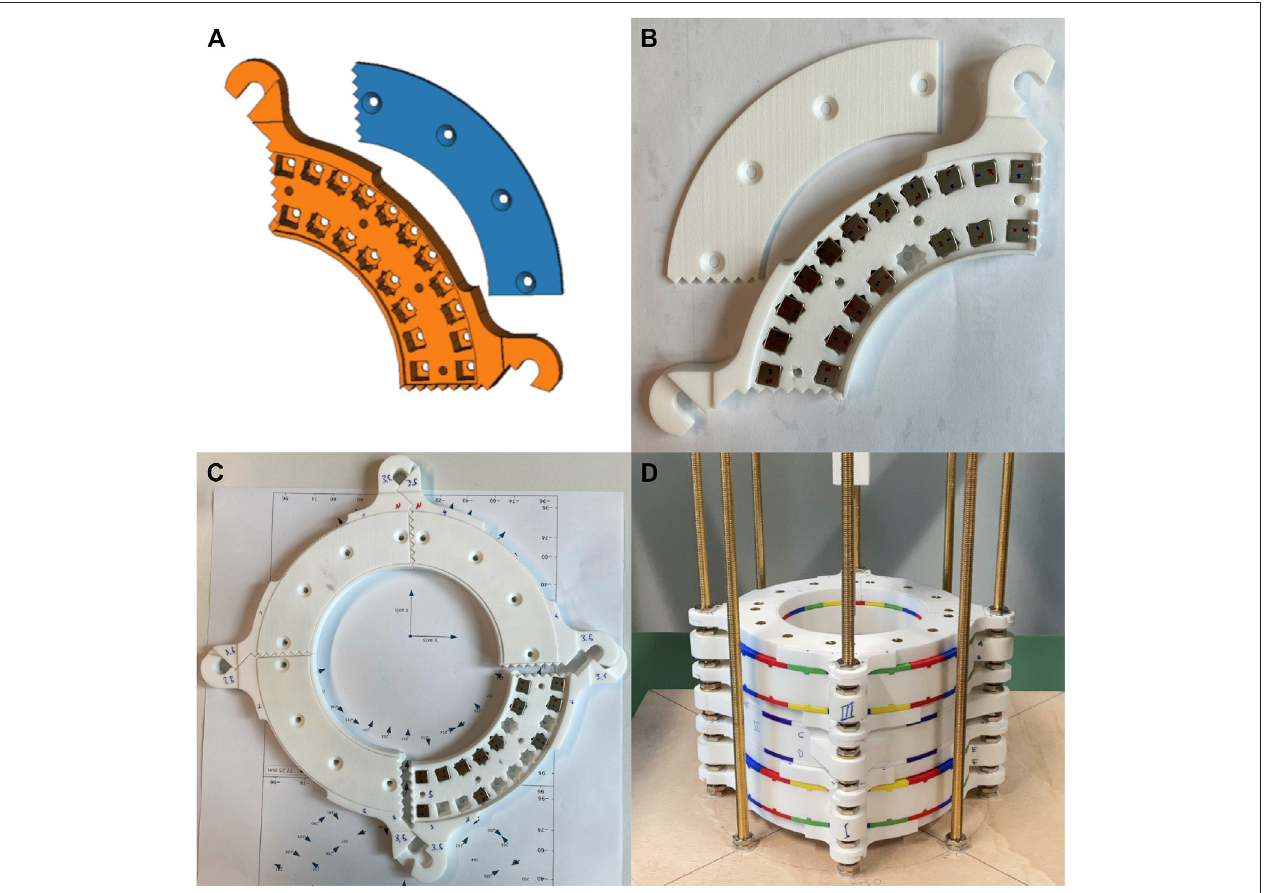
FIGURE 2 | Photographs and 3D renderings of the constructed and assembled shim pieces including the 9 mm cubic shim magnets. (A) CAD drawing of a single shim piece (orange) and cover (blue). Please note that the pockets are designed in a way that the shim magnets can be inserted in both radial (k (cid:1) 1) and Halbach (k (cid:1) 2) orientation. (B) 3Dprintedshimpiecewithinsertedmagnetsandthecoverremoved.Thepolesofthemagnetsaremarkedwithnorth(N)andsouth(S). (C) Illustrationofa fully assembled shim ring constructed from four shim pieces. (D) Photograph of the fully assembled base magnet including all shim inserts.